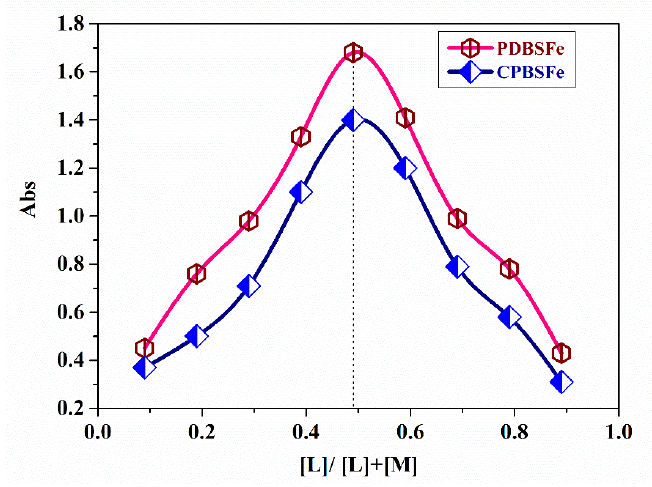
Table 3. The constant of formation (Kf), constant of stability (pK), and Gibbs free energy ∆ (G*) val- ues for the investigated Fe(III) chelates at 298